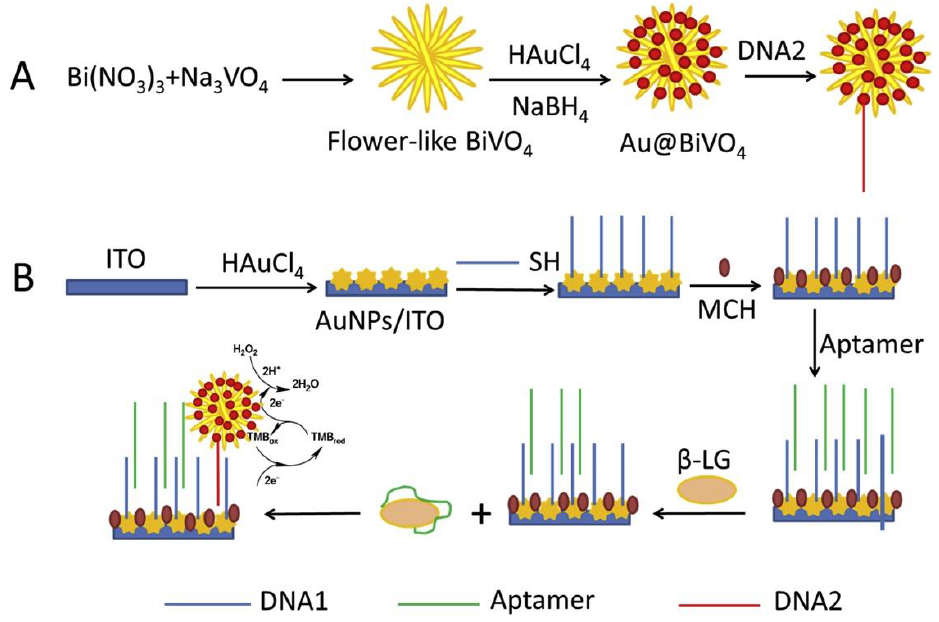
Figure 7. Scheme of the β -LB detection strategy. ( A ) Preparation of the DNA2/Au@BiVO 4 probe; ( B ) assembly of the aptasensor and electrochemical detection of β -LB. Reprinted with permission from [117]. Copyright 2020, Elsevier.